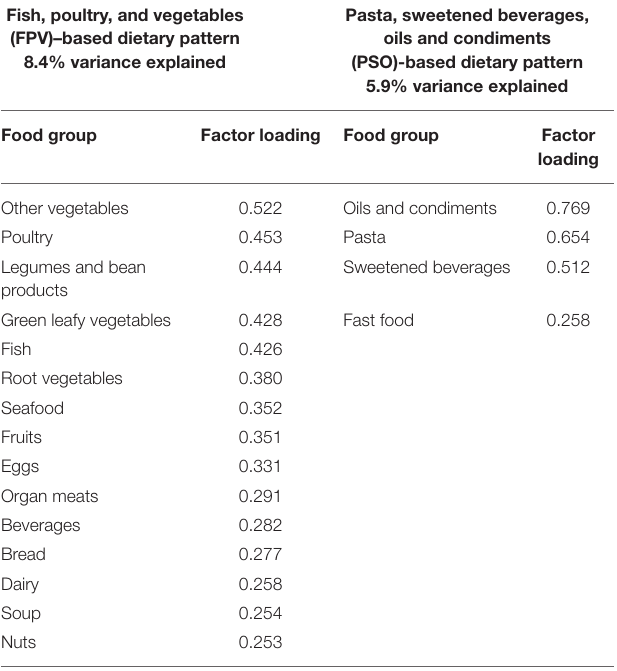
scores on the MDI ( Table 5 ), gestational age at delivery, odds of preterm birth, preeclampsia, GDM, SGA, or macrosomia, infant subscapular skinfolds, or mid-arm circumference ( Supplementary Tables 1, 2